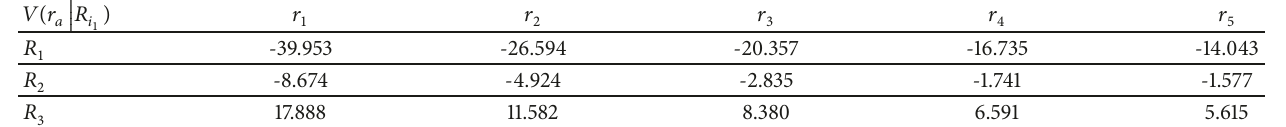
Table 7: The prospect value of RPP.